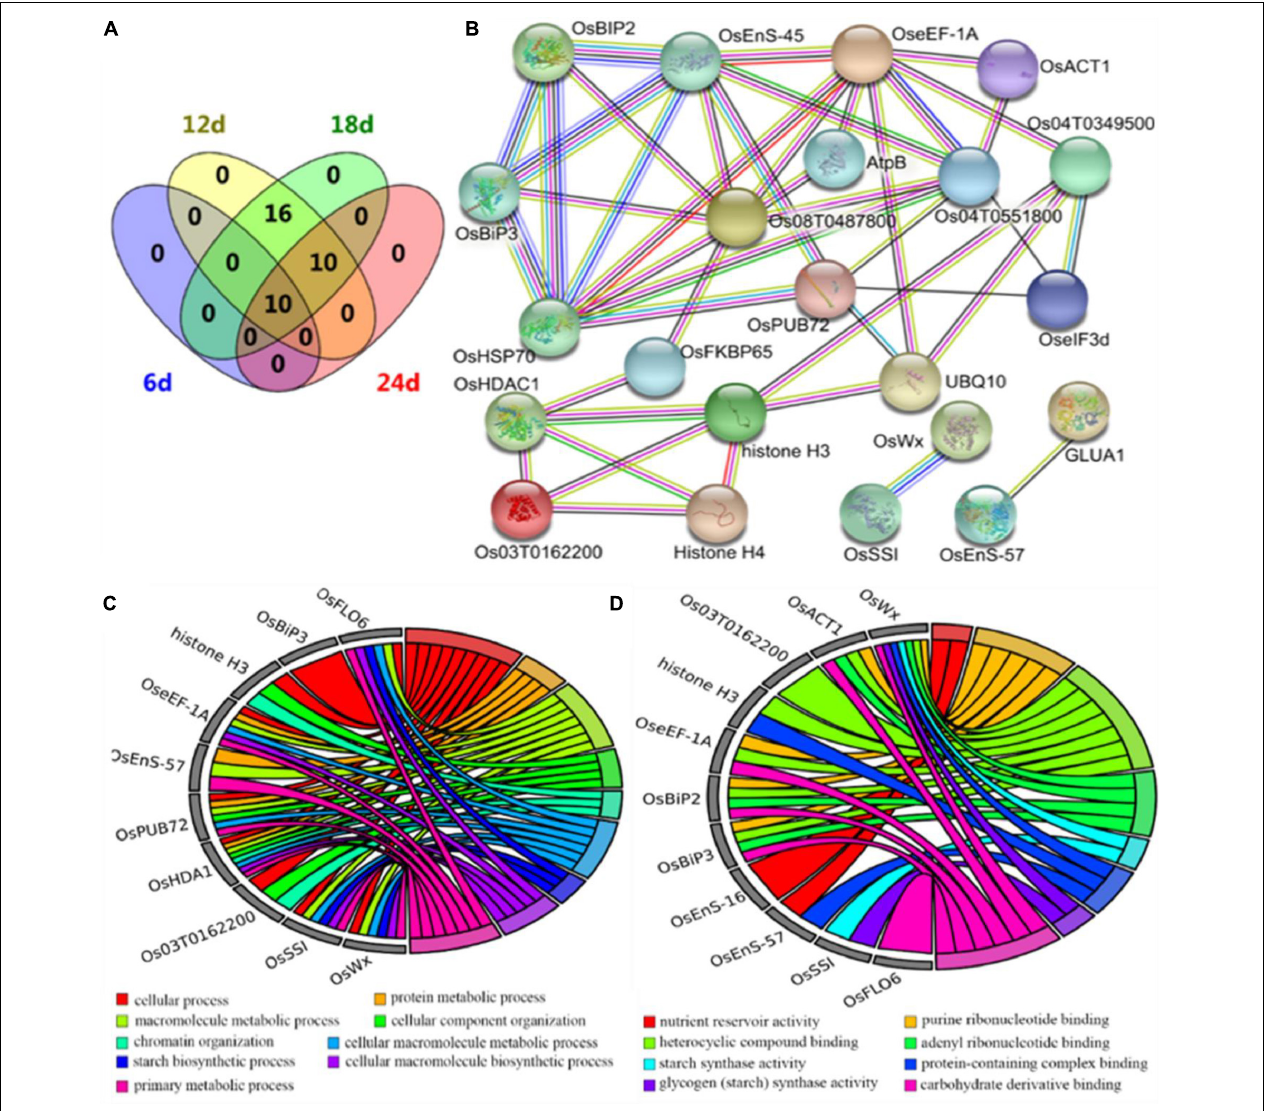
FIGURE 9 | Differentially expressed proteins from proteomics analysis. (A) Venn diagram of differentially expressed proteins. (B) The interaction network of differentially expressed proteins. DeepSkyBlue1 line, from curated databases; DeepPink3 line, experimentally determined; Green line, gene neighborhood; Red line, gene fusions; Blue line, gene co-occurrence; OliveDrab3 line, text mining; black line, co-expression; MediumSlateBlue line, protein homology. (C) Biological process enrichment map from GO analysis. (D) Molecular function enrichment map from GO analysis.